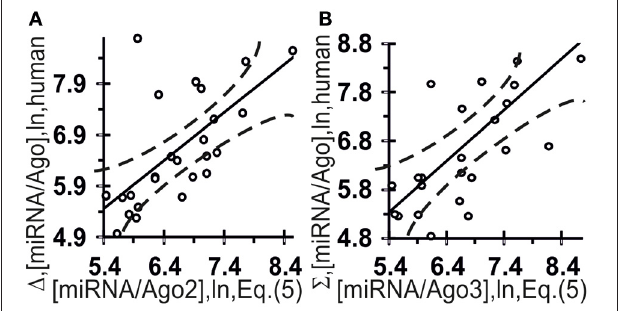
FIGURE 6 | Control test of the final Equation (5), the x -axis, derived with ACTIVITY outputs (Ponomarenko et al., 1997) on the training dataset (Table 2) and using independent experimental data (the y -axis) on the canonical miRNAs taken from the same data source (Azuma-Mukai et al., 2008). miRNA/Ago affinity as measured in vivo (Azuma-Mukai et al., 2008) and as estimated in silico and expressed in logarithms are statistically significantly correlated for Ago2 (A) and Ago3 (B) . Dashed curves and solid lines as in the legend to Figure 3 .